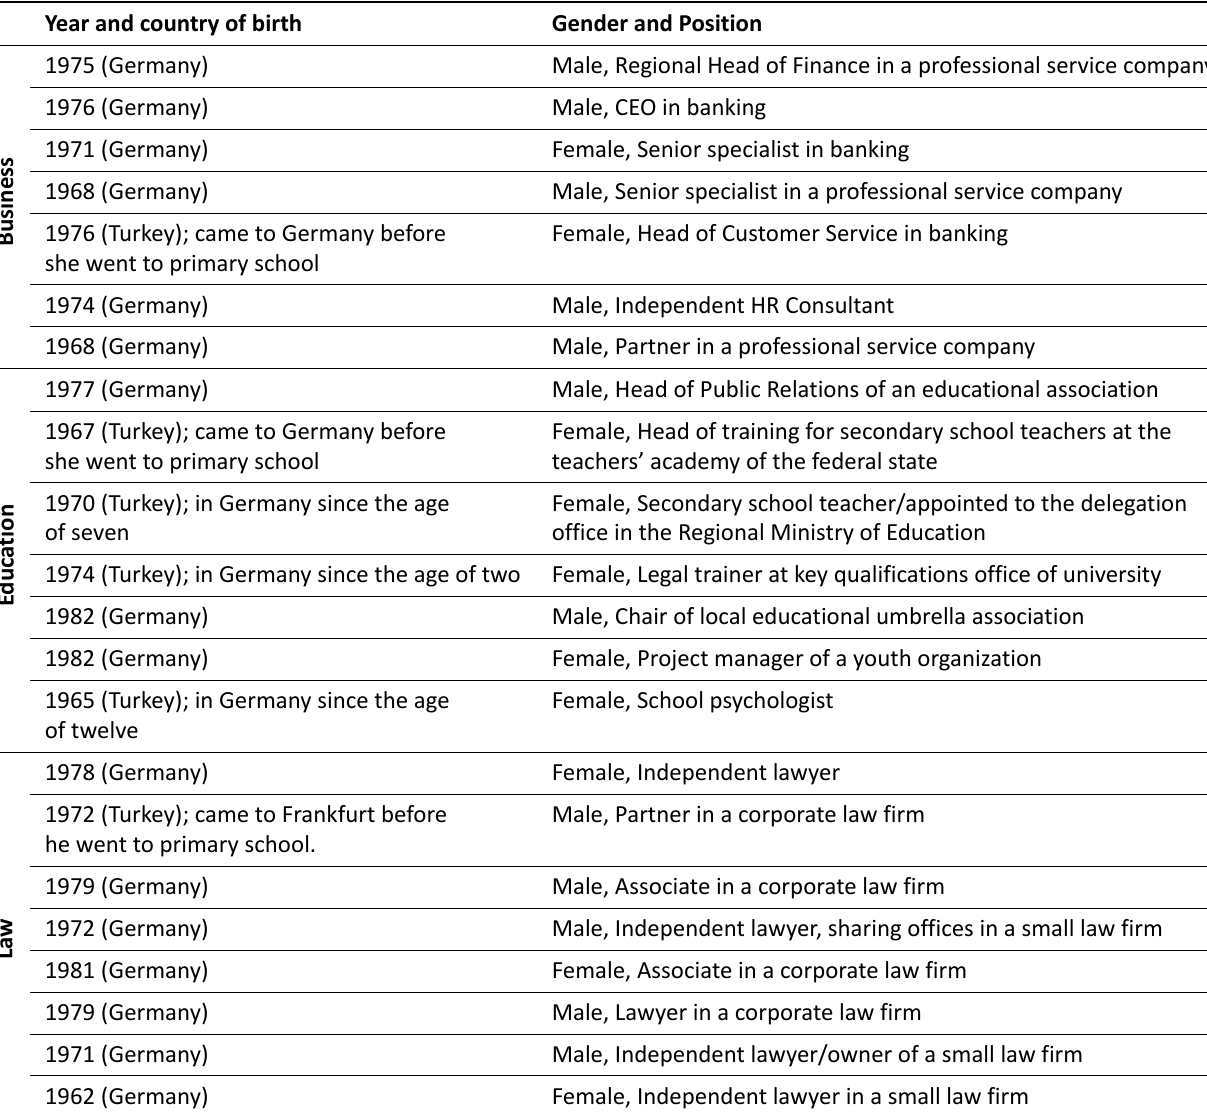
Table 1. Overview of